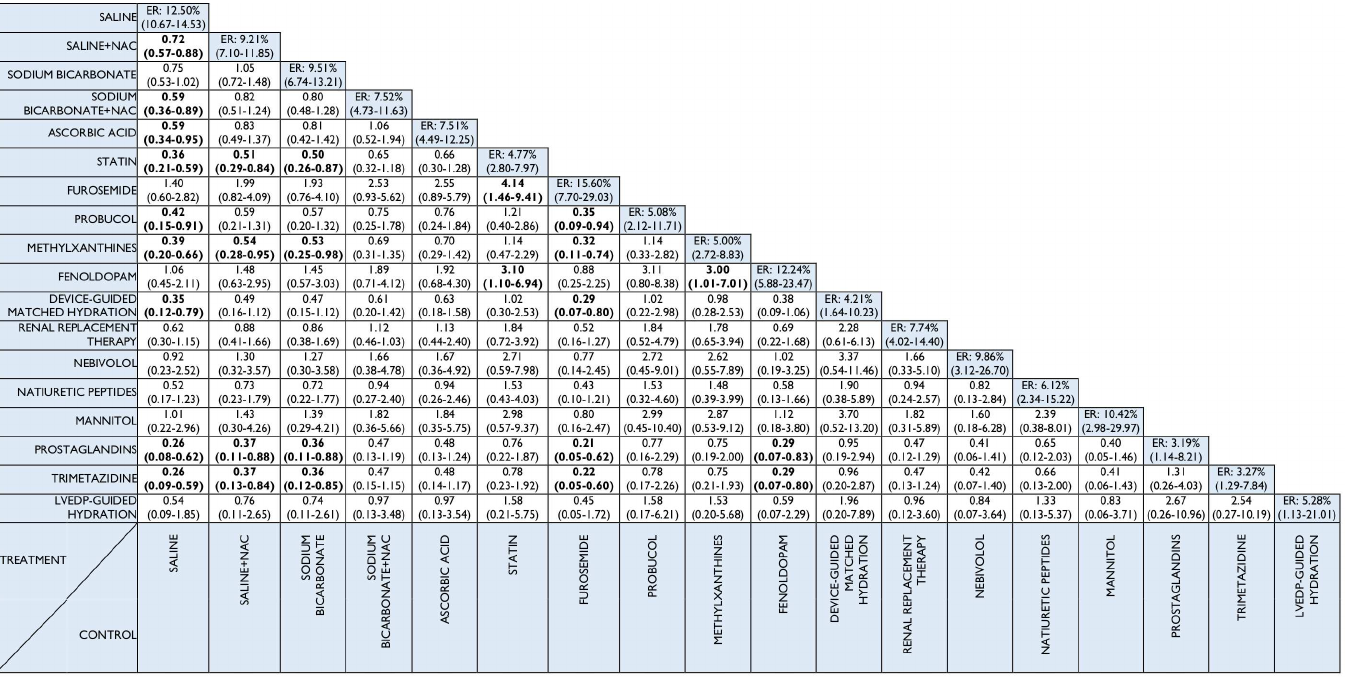
Fig 3. Network meta-analysis odds ratios and 95% credible intervals for contrast-induced acute kidney injury. Comparisonsbetweentreatments should be read from left to right. Estimates of treatment effects in the cell in common betweenthe row-definingtreatment and the column-definingtreatment. Odds ratios lower than 1 favour the row-definingtreatment. To obtain odds ratios for comparisons in the oppositedirection, reciprocals should be taken. Significantresults are in bold and underlined. ER = event rate; LVEDP = left ventricular end-diastolicpressure; NAC =